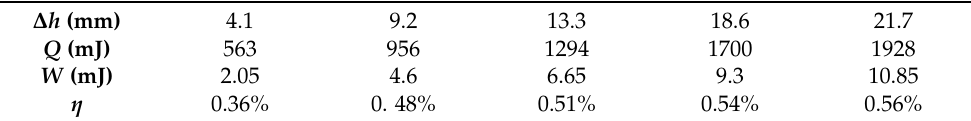
Table 2. Efficiency of joint actuator.